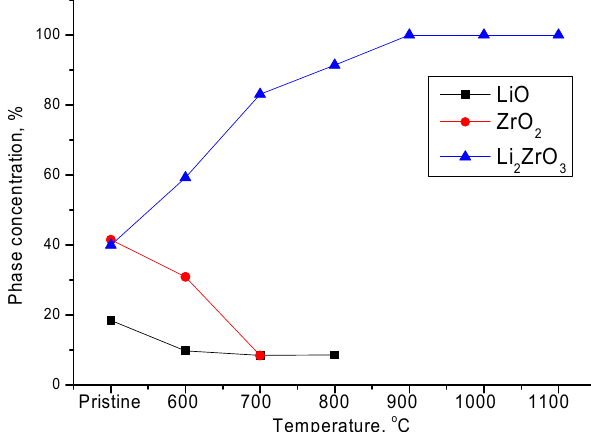
Figure 3. Phase diagram of the studied ceramic samples versus annealing temperature.